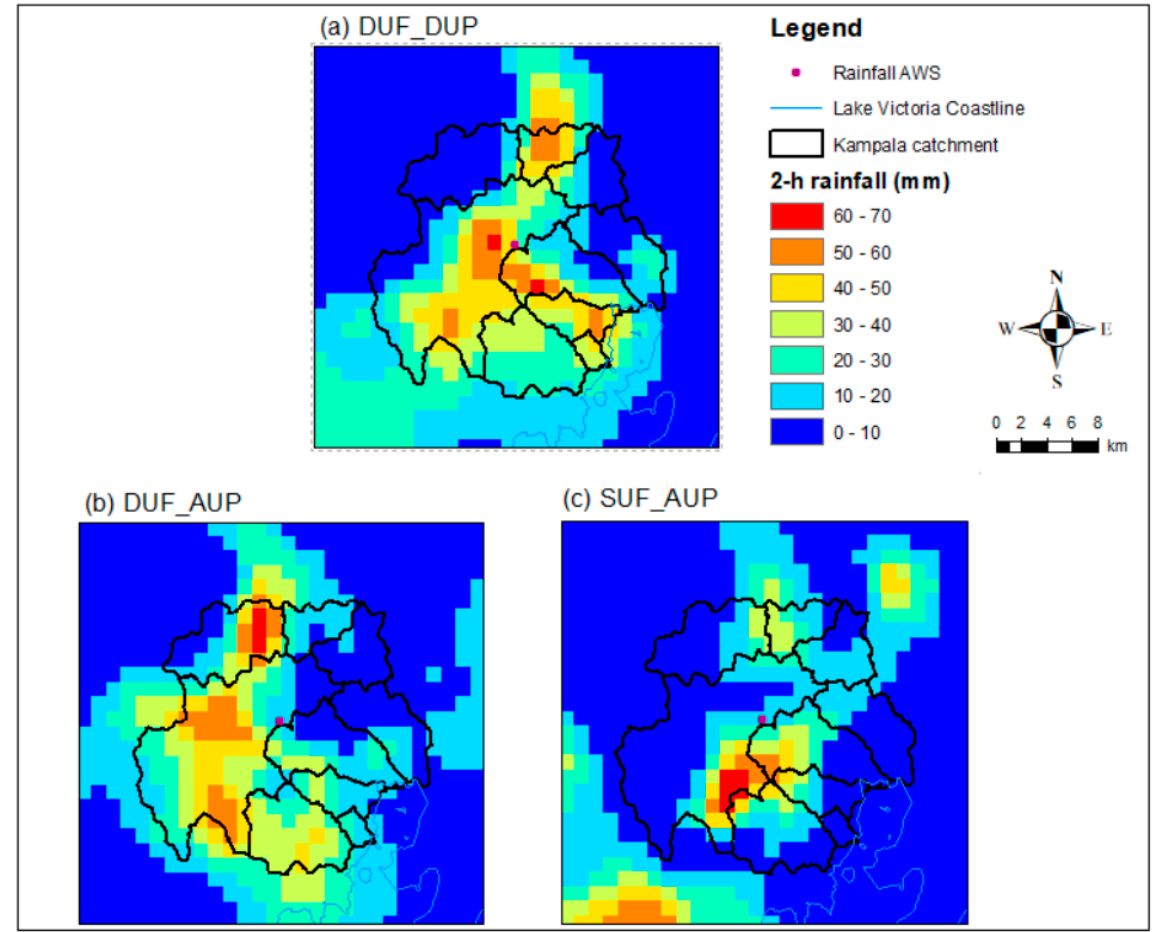
Figure 6. 2 h accumulated rainfall distribution for model simulations for the period of 11:00–12:50 UTC on 25 June 2012 (the same period as the observed rainfall using AWS in Kampala): ( a ) DUF_DUP, ( b ) DUF_AUP, and ( c ) SUF_AUP simulations.